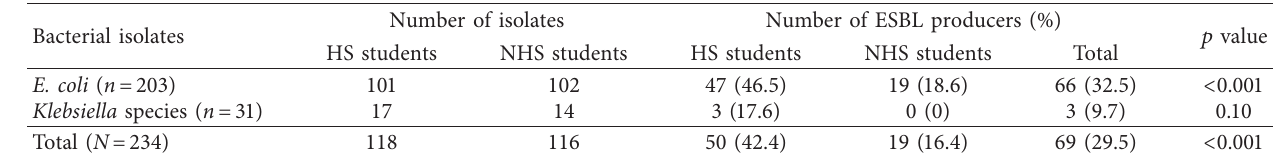
Table 3: Prevalence of fecal carriage of ESBL-producing isolates.